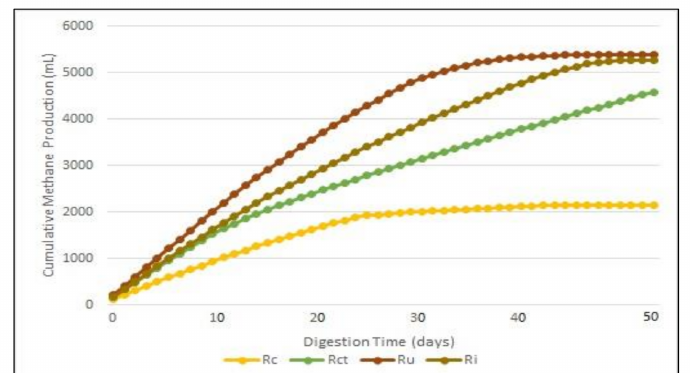
Figure 4. The impact of NPs on cumulative methane generation in R u , R i , and R ct bioreactors with respect to R c (control bioreactor).